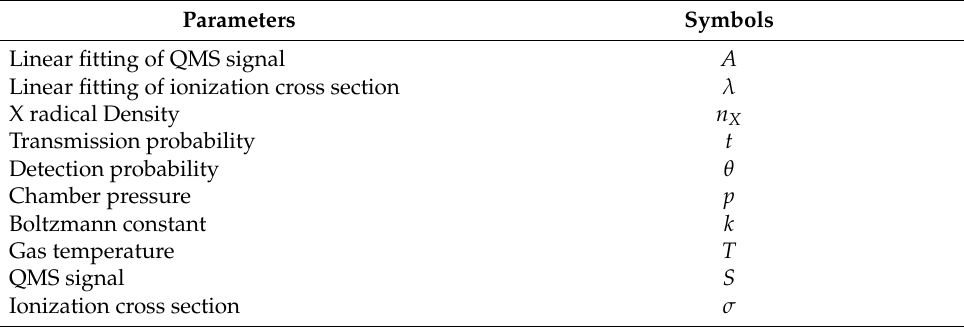
Table 1. Symbols representing the parameters used in Equations (1)–(3). Parameters